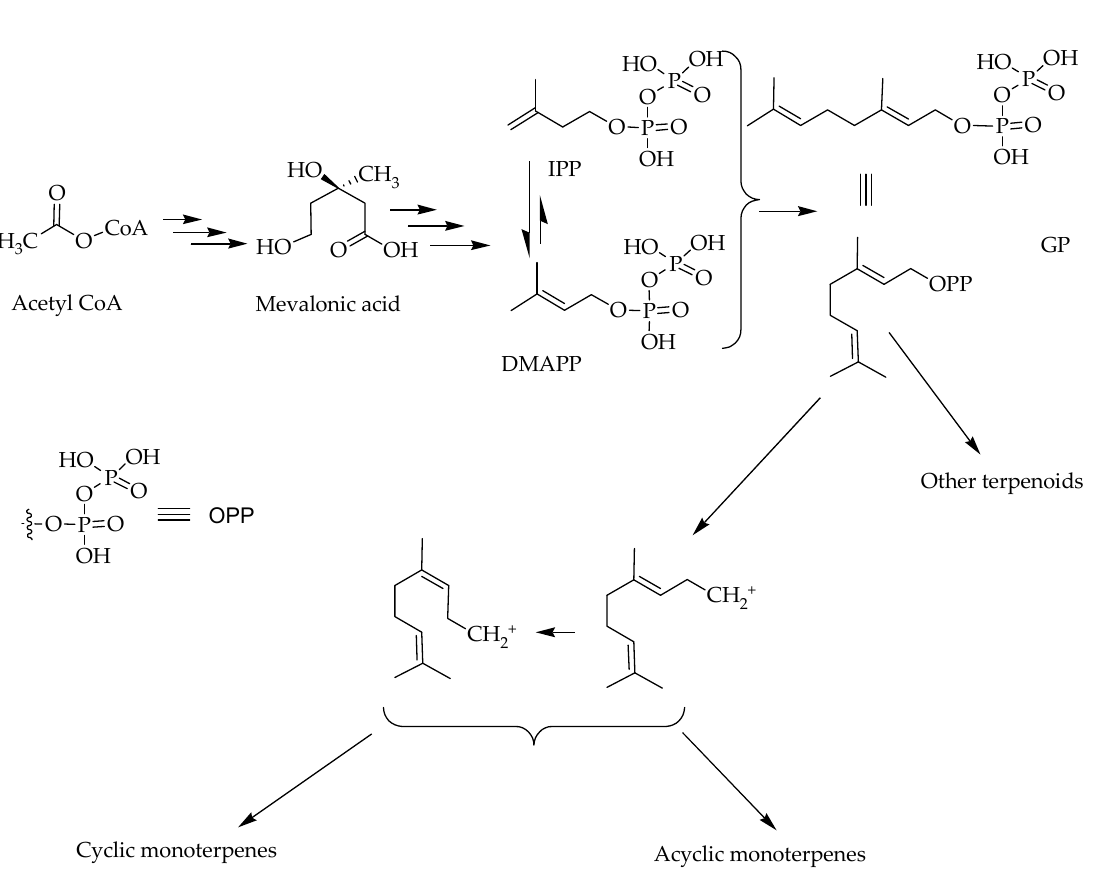
Figure 1. An overview of biosynthesis pathway of monoterpenes; isopentenyl diphosphate (IPP) and dimethylallyl diphosphate (DMAPP); glycogen phosphorylase (GP); OPP: diphosphate leaving group.